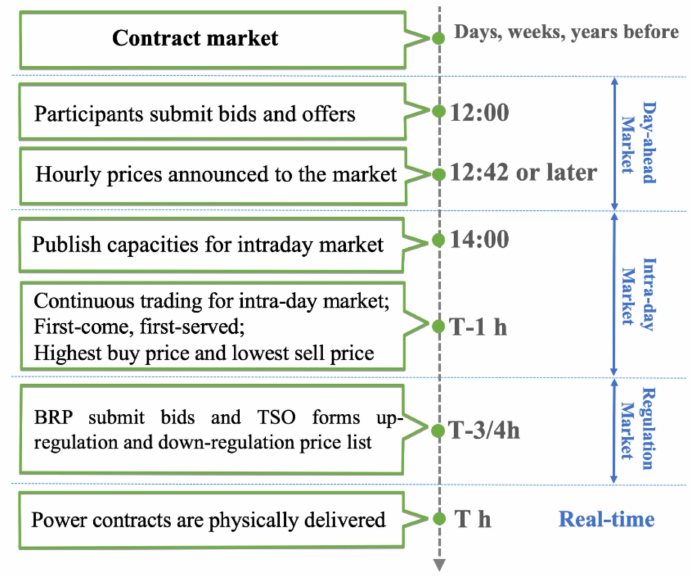
Figure 7. The clearing process of Nord